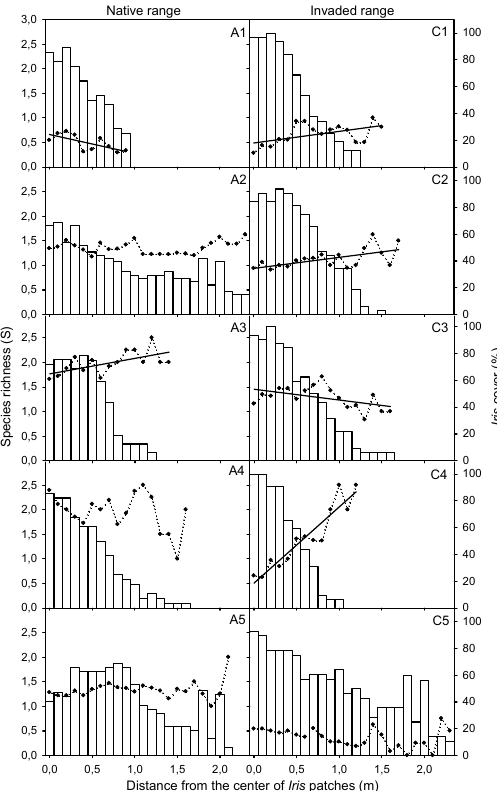
Figure 6. Relationship between species richness (S) and distance (m) to the center of Iris pseudacorus population patches in Andalusia ( A1–A5 ), Guadalquivir Estuary (native range), compared to this relationship in California ( C1–C5 ), San Francisco Bay-Delta Estuary (invaded range). Columns in- dicate relative cover (%) of I. pseudacorus . Regression equations: ( A1 ) y = 0.663 − 0.385 × (R = − 0.699, p = 0.05, n = 10); ( C1 ) y = 0.490 + 0.235 × (R = 0.532, p = 0.034, n = 16); ( C2 ) y = 0.939 + 0.224 × (R = 0.600, p = 0.008, n = 18); ( A3 ) y = 1.768 + 0.315 × (R = 0.613, p = 0.015, n = 15); ( C3 ) y = 1.455 − 0.221 × (R = − 0.497, p = 0.042, n = 17); ( C4 ) y = 0.506 + 1.552 × (R = 0.942, p < 0.0001, n = 13).